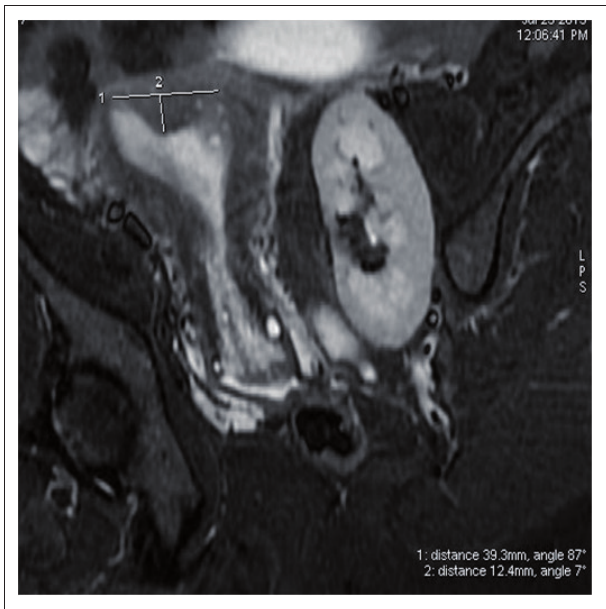
FIGURE 8: Coronal oblique T2 sequence shows no fundal external dipping, an intercornual distance of less than 4 cm and an internal fundal muscular indentation of more than 50 % of the uterine wall thickness. Associated left pelvic kidney is seen. Note: Diagnosis: The European Society of Human Reproduction and Embryology–European